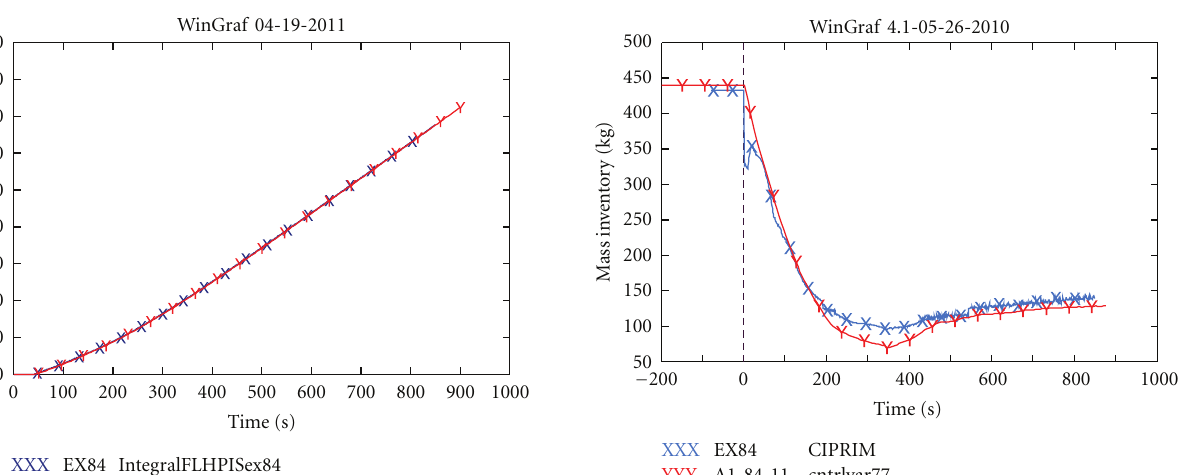
Figure 24: Integral break flow rate.